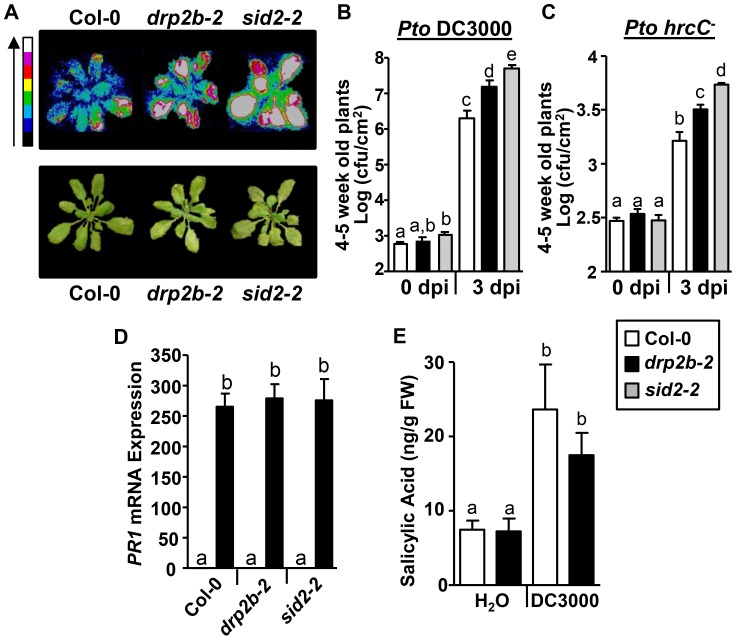

drp2b single mutants are more susceptible to Pseudomonas syringae pv. tomato (Pto) DC3000 and Pto hrcC− infection.(A) In planta growth of Pto DC3000 LuxCDABE (DC3000lux) in 4–5 week old Col-0, drp2b-2 (2b-2), and sid2-2 plants. Plants were imaged at 3 days post infiltration (dpi) after syringe-infiltration with DC3000lux (OD600 = 0.0005) by bright field or with a Photek camera. A representative plant is shown for each genotype and treatment. Color scale bar indicates increasing photon intensity. (n = 4 plants/genotype and treatment). (B) Compared to Col-0 (white bars), bacterial growth was significantly increased in drp2b-2 plants (black bar) (P<0.0065) at 3 dpi with DC3000lux (OD600 = 0.0005) as measured by serial dilution plating. sid2-2 served as control (gray bars; sid2-2 to Col-0: P<0.0001; to drp2b-2: P<0.02). (n = 7-12/genotype and treatment). (C) Compared to Col-0 (white bars), bacterial growth was significantly increased in drp2b-2 plants (black bar) (P<0.01) at 3 dpi with Pto hrcC- (OD600 = 0.02) as measured by serial dilution planting. sid2-2 served as control (gray bars; sid2-2 to Col-0: P<0.0001; to drp2b-2: P = 0.0005). (n = 6/genotype and treatment). (D) Using qRT-PCR, no difference in PR1 mRNA levels was observed between drp2b-2, sid2-2 and Col-0 24 hrs after treatment with 50 µM exogenous SA (black bars). Treatment with water (H2O; white bars) served as mock control. (n = 4/genotype an treatment). (E) Levels of SA in drp2b-2 (black bars) compared to Col-0 (white bars) at 24 hr post infection (hpi) with Pto DC3000lux (OD600 = 0.02) (P = 0.375). Treatment with water (H2O; white bars) served as mock control (P = 0.91). (n = 4/genotype and treatment; with each n containing 6 seedlings). Experiments in (A-C) and in (D-E) utilized 4–5 week or 2 week old plants, respectively. All experiments were repeated three times with similar results. Values are mean ± SE. Statistical analysis was done as in Fig. 1.